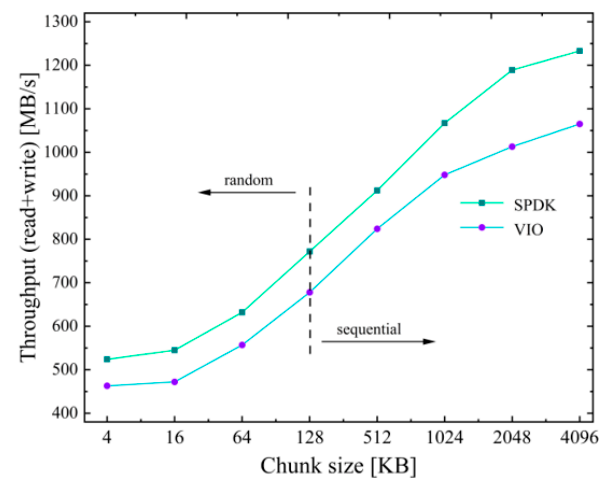
Figure 12. Throughput comparison of different block device drives.